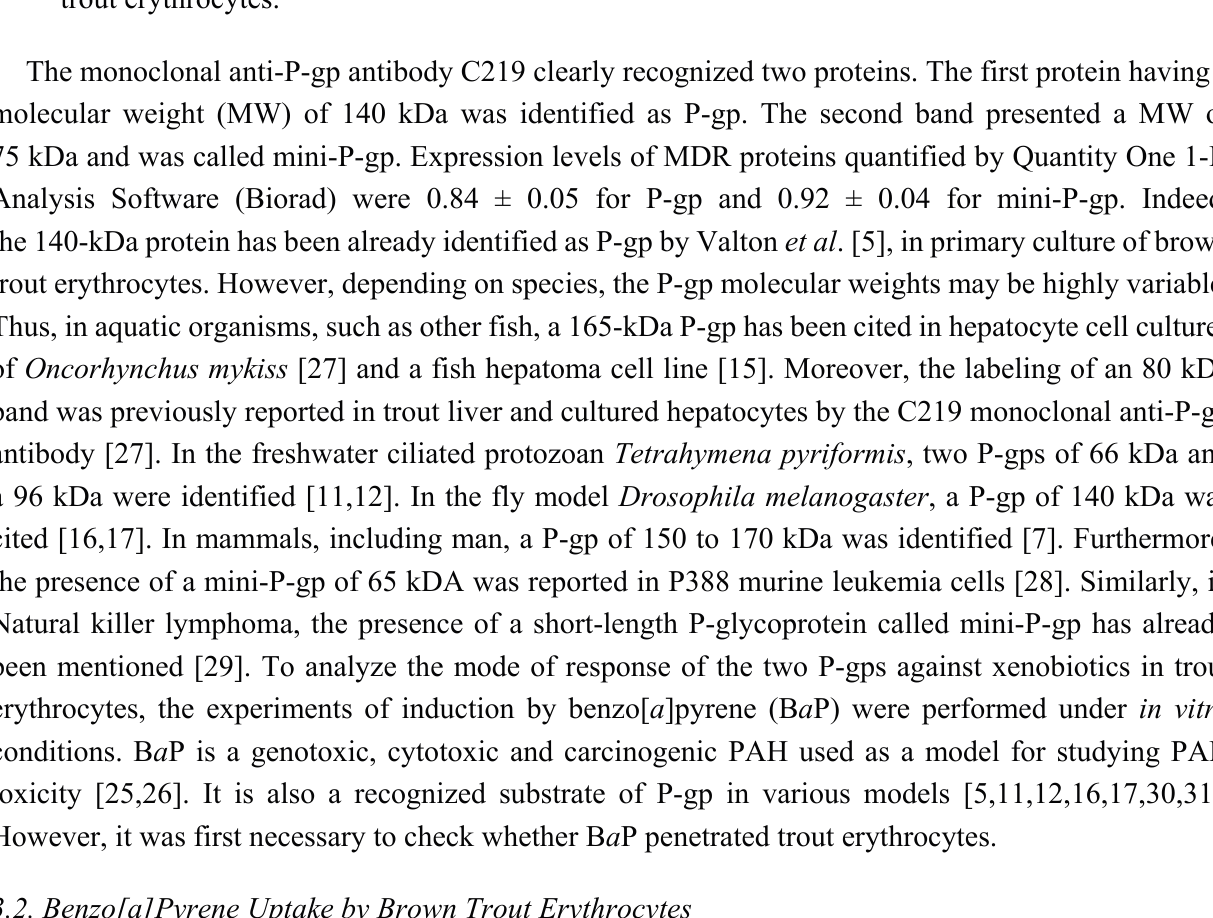
Figure 1. MDR protein expression in brown trout erythrocytes by Western blot analysis. MDR protein expression was studied in total protein extract from dry pellets of brown trout